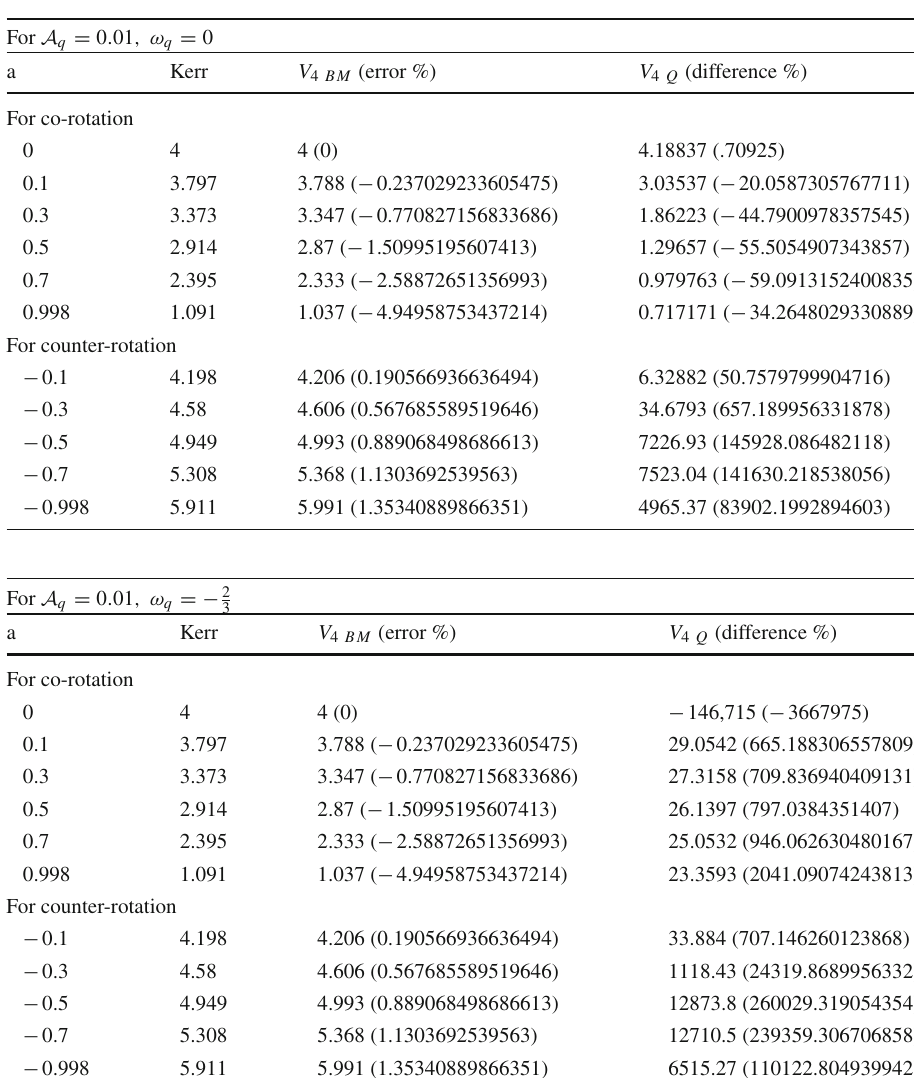
PNPs for moderate DE effect in pressure-less dust